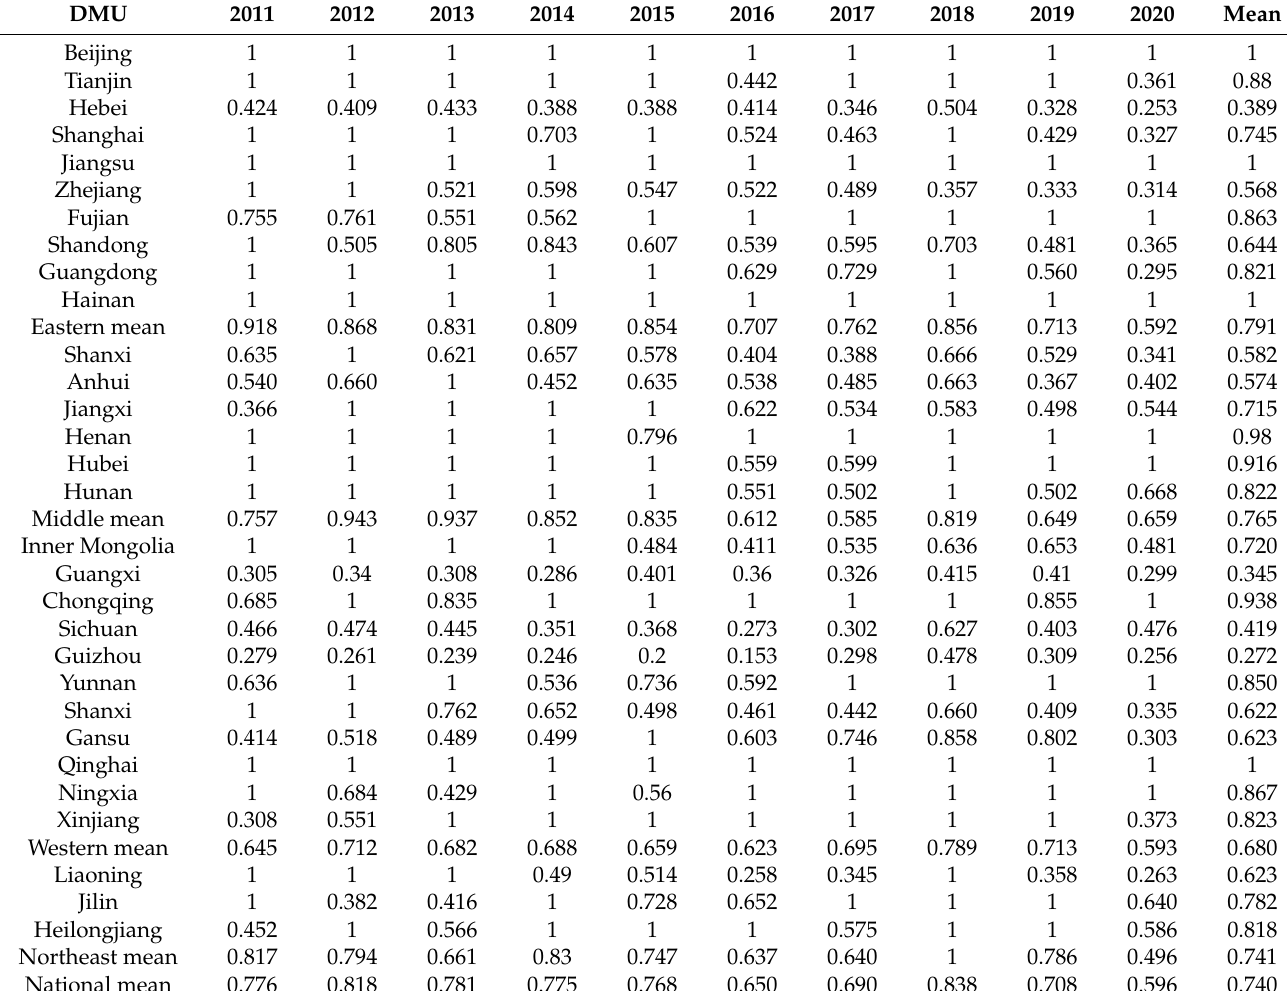
Table 3. Static results for environmental efficiency of construction waste